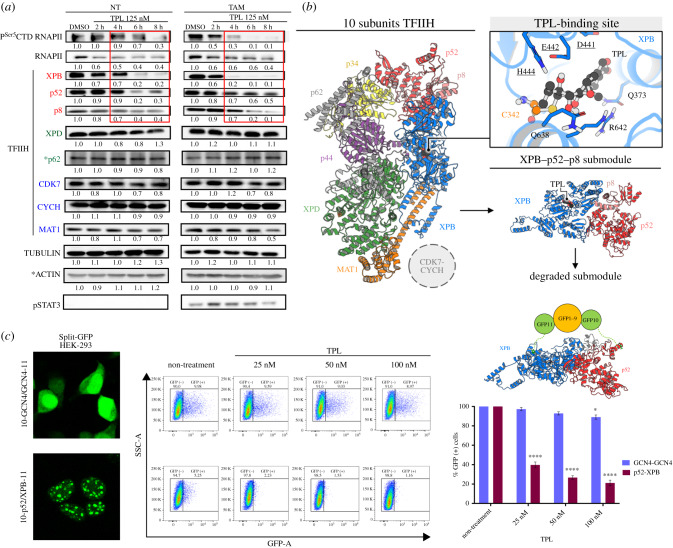
TPL induces the degradation of the XPB–p52–p8 submodule of TFIIH. (a) Western blots showing RNAPII CTD and the pSer5CTD RNAPII, and some TFIIH subunits (XPB, p52, p8, XPD, p62, CDK7, CYCH and MAT1) from cells incubated with TPL 125 nM for 2, 4, 6, 8 h in comparison to the control with DMSO for 8 h. (*) Independent western blots using the same extracts. Note that the TFIIH subunits, XPB, p52 and p8 protein levels decrease as the incubation time with TPL advances (box in red). Densitometric analyses were performed using tubulin and actin (only for p62) as loading control; the relative quantification is indicated under each blot and the data showed as a representative example from three biological replicates. The p-STAT3 is used as a transformation control. (b) Computational molecular dynamics model that proposes the mechanism of the XPB–p52–p8 submodule dissociation from the TFIIH complex and degradation due to the covalent binding of TPL to XPB. The figure on the left shows the three-dimensional structure of TFIIH coloured by its components: XPB (blue), XPD (green), p8 (pink), p34 (yellow), p44 (purple), p52 (red), p62 (grey) MAT1 (orange). The upper right figure depicts TPL (black) binding mode in XPB. TPL binding site (TBS) residues are shown in blue, underlining the DEVH box amino acids, and C342 forming the covalent bond with TPL is highlighted in orange. (c) TPL interferes with the p52–XPB interaction. A representative image from at least three independent Split-GFP complementation assays between the p52 and XPB subunits expressed in HEK-293 cells is shown in the left panel. The middle panel shows an example of the cytometry measure of the GFP fluorescent activity by the cell in the GCN4-GCN4 split-GFP homodimer complementation used as control and the p52–GFP–XPB split complementation. Note that at 25 nM of TPL incubation by 28 h practically no fluorescent cells in the p52–XPB construct are detected. The right panel shows a kinetic assay of three independent experiments where the percentage of live and positive cells for GFP is shown. Significant differences were analysed by Two-way ANOVA with corrections for multiple comparisons, always comparing with the non-treated column. Statistical significance is indicative *p < 0.05, ****p < 0.0001. The structure at the top of the histogram depicts the p52–GFP–XPB complementation, showing that the localization of the GFPs is compatible with the formation of a functional TFIIH complex with a reasonable distance between fused GFP10 and GFP11 fragments.